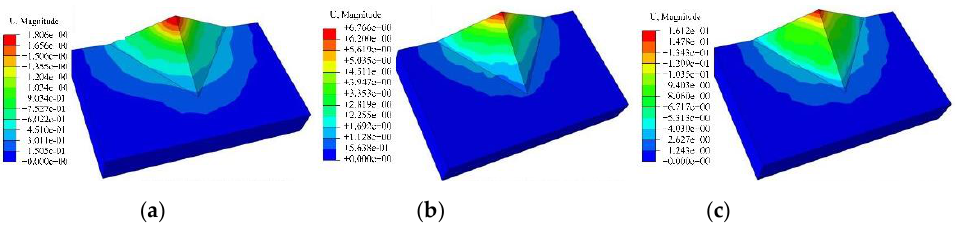
Figure 11. Displacement cloud map of ridge slop under different slope high (Unit: m) (a) H =10m; (b) H =20m; (c) H =30m. ( b ) H = 20 m; ( c ) H = 30 m.